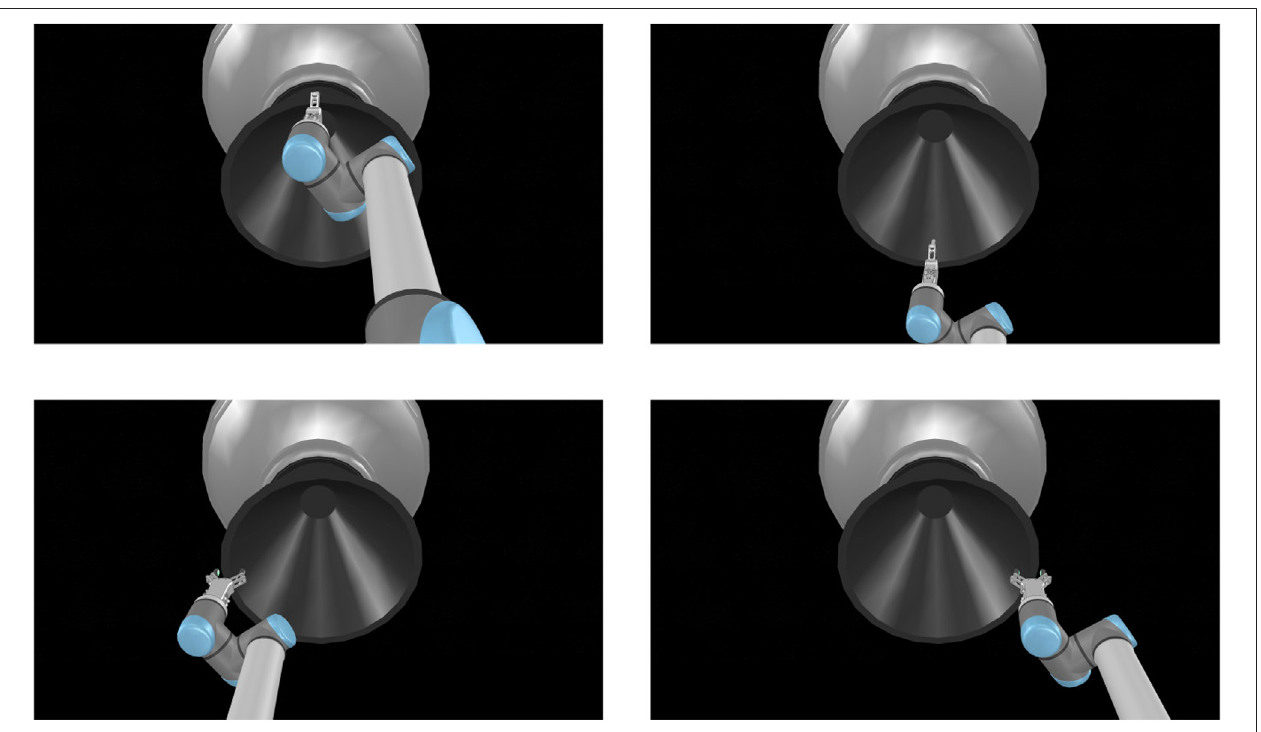
FIGURE 6 | The four grasping points for each target of the simulation, shown here for STAR-48c: Top grasp (upper left image) , bottom grasp (upper right image) , left grasp (bottom left image) , and right grasp (bottom right image) .